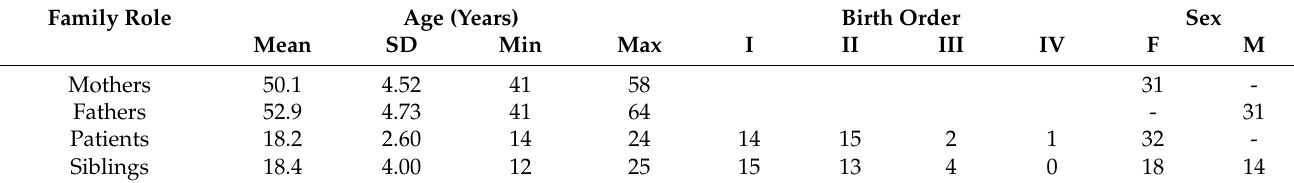
Table 1. Demographic